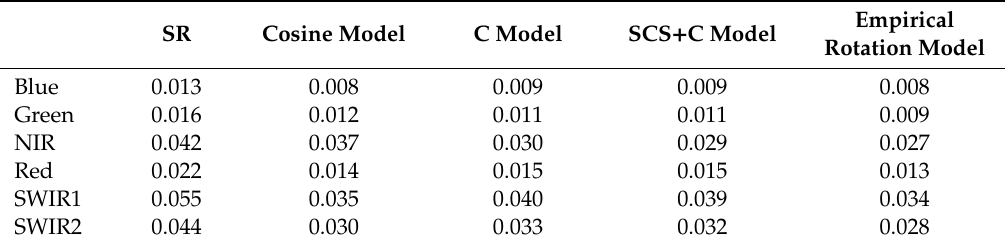
Table 2. Standard deviation statistics of spectral bands before and after topographic correction. SR refers to “surface reflectance” and represents precorrected conditions. The model represents the conditions after topographic corrected by the specify